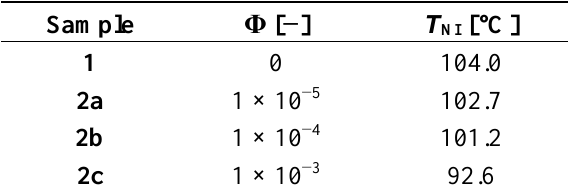
Table 1. Nematic-isotropic phase transition temperatures of 1 and 2a – c .